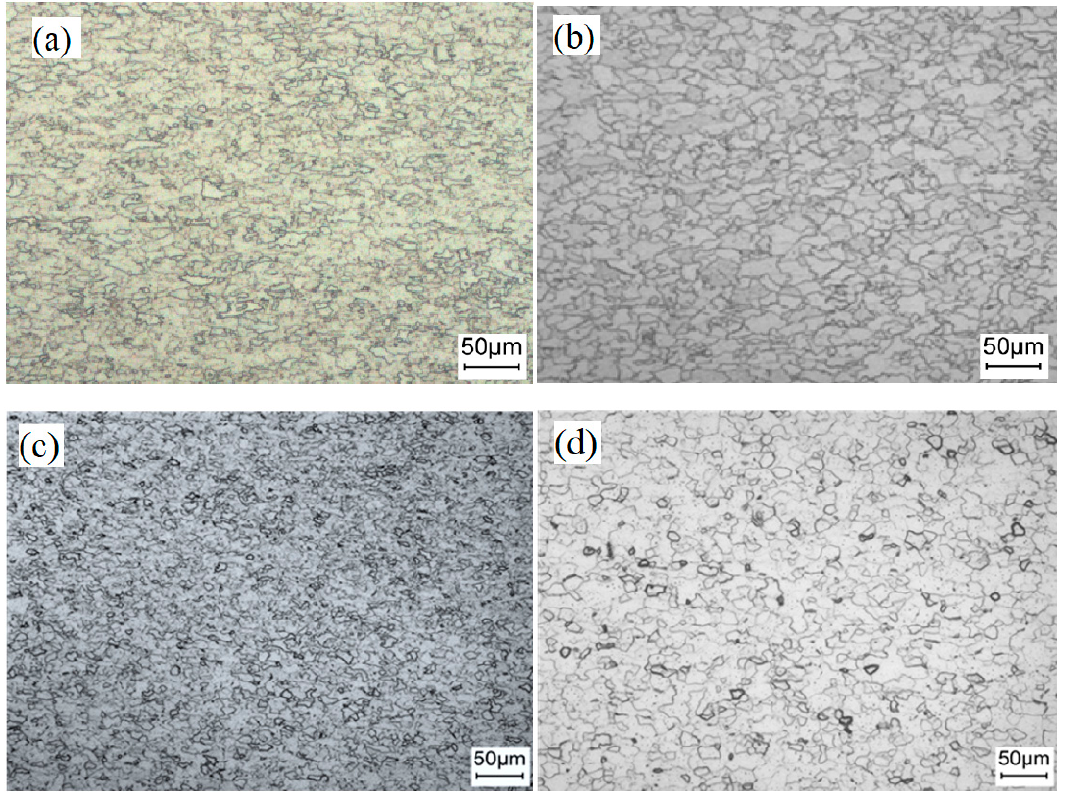
Figure 6. Comparison of microstructure of strip during rolling process. 1#: ( a ) HR, ( b ) CA. 2#: ( c ) HR, ( d ) CA.